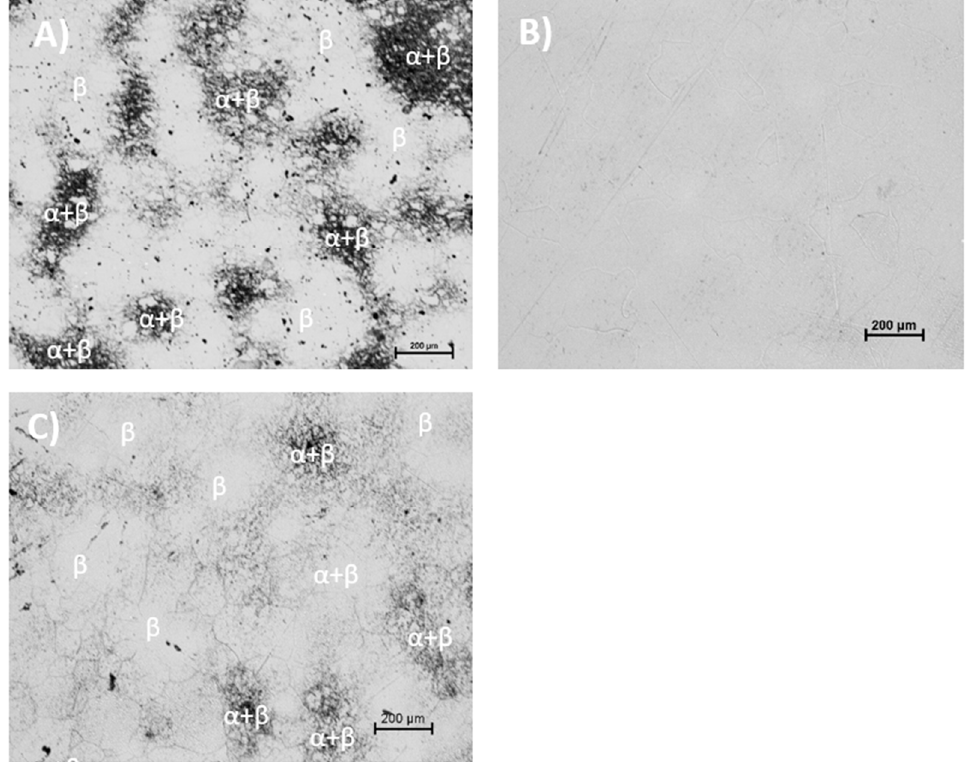
Figure 2. The microstructure of Ti35Nb2Sn according to its manufacturing condition. ( A ) Conventional vacuum sintering at 1350 °C for 180 min. ( B ) HIPed under 1200 °C, 150 MPa, and cooling rate 500 °C/min. (HIP 1) ( C ) HIPed under 1200 °C, 150 MPa, and cooling rate 100 °C/min (HIP 2).